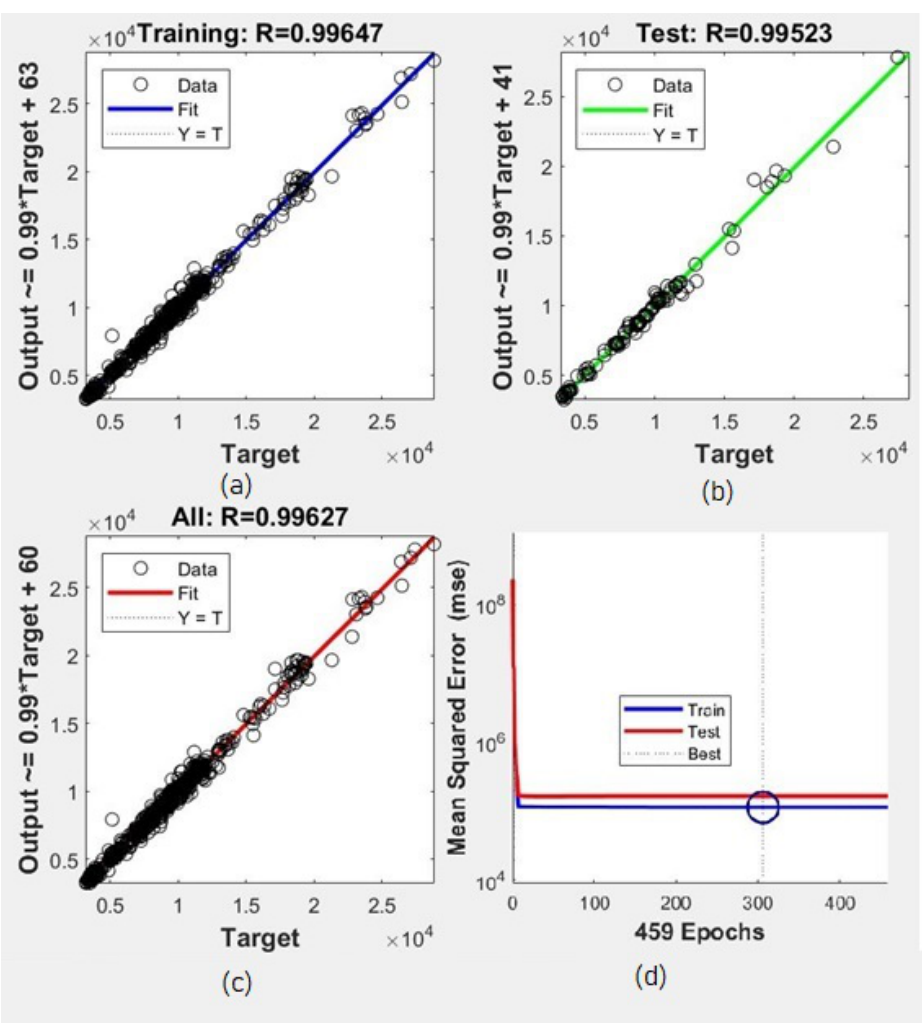
Figure 10. ANN model diagnostics. Validation Performance plot are displayed by the regression plots. ( a ) Training data set, ( b ) Testing data set, ( c ) Overall data set, and ( d ) Epoachs vs.